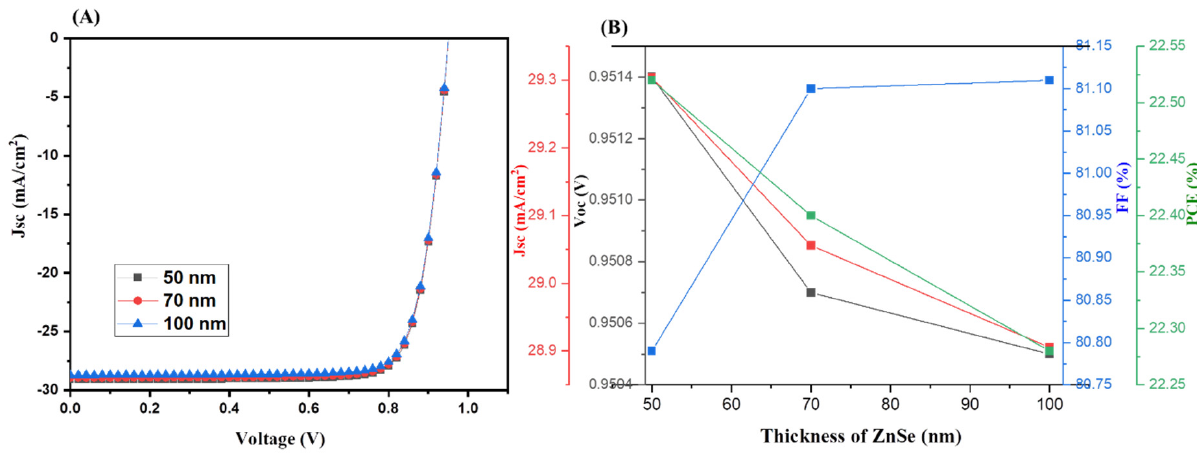
Figure 5. J–V curves ( A ) and photovoltaic parameters ( B ) of tandem PSCs using ZnSe (with different